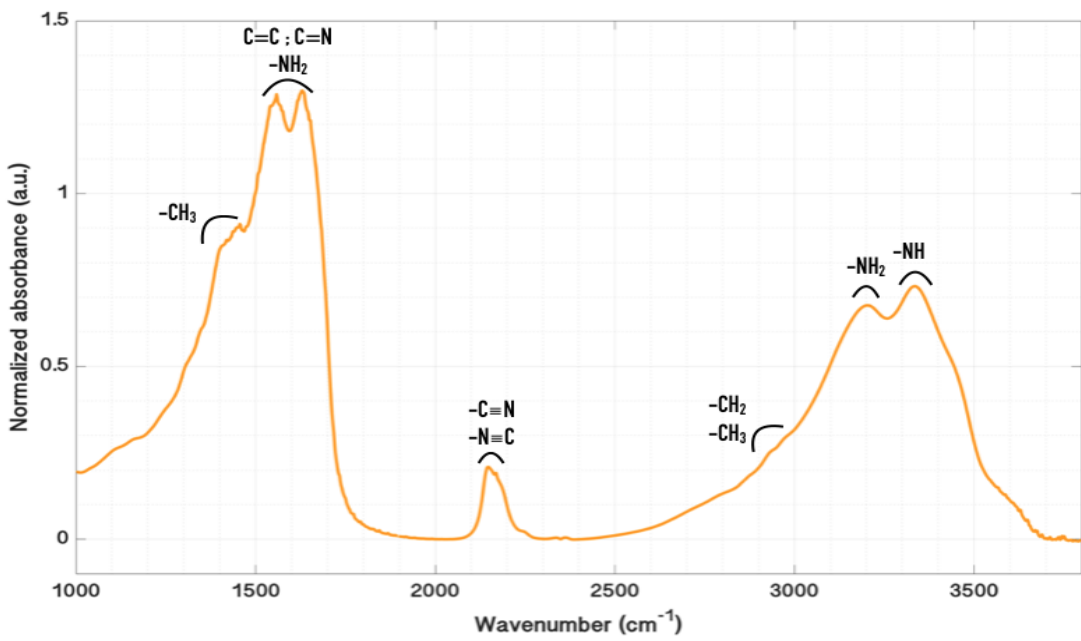
Figure 3. Absorption spectrum in the mid-IR range (1000–4000 cm − 1 ) corresponding to Titan’s tholins, realized with infrared transmission spectroscopy. The analysed tholin sample was pressed into a pellet with a KBr matrix.